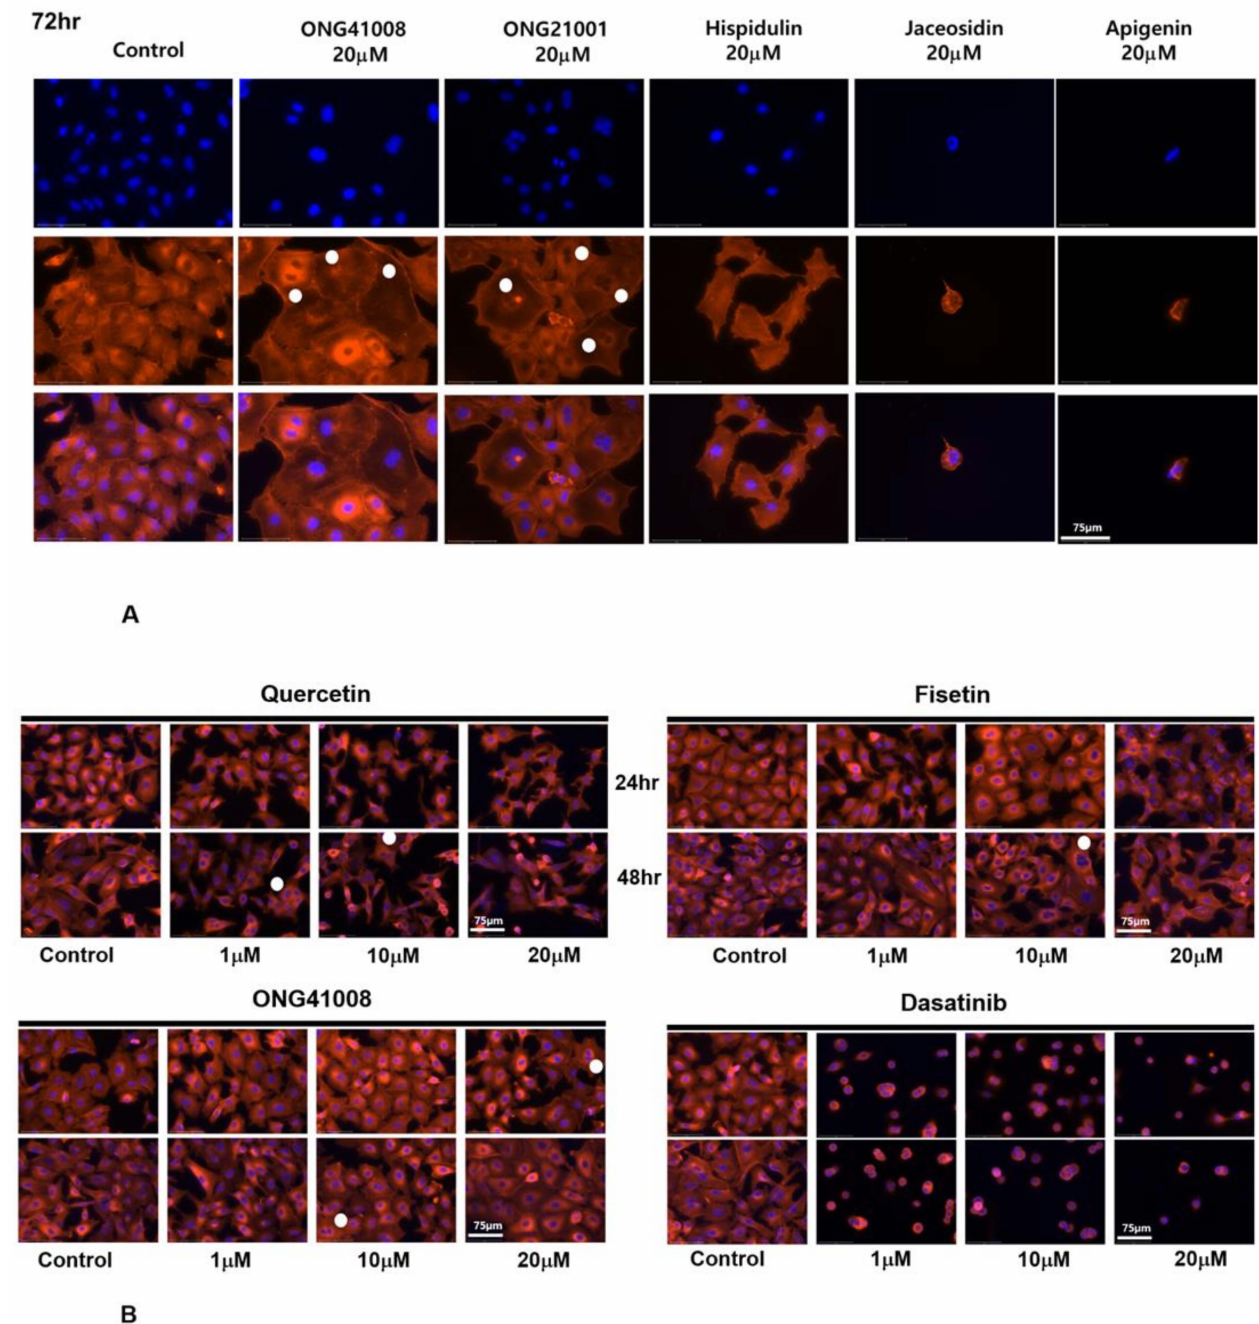
Figure 6. Cellular senescence and the senolytic capability: comparison between quercetin, fisetin, ONG41008, and dasatinib. ( A ) ONG41008 and ONG21001 induced cellular senescence leading to multinucleation. A549 cells were stimulated with 20 µ M ONG41008, ONG21001, hispidulin, jaceosidin, or apigenin for 72 hr and subjected to ICC using DAPI and phalloidin. MNCs are denoted by white circles. ( B ) Comparison of the morphological changes upon stimulation of A549 with ONG41008, quercetin, fisetin, or dasatinib. Taken together, ONG41008 is a potent inducer of cellular senescence in cancer cells and contains CS but is distinguished from quercetin and fisetin, which are generally known to be